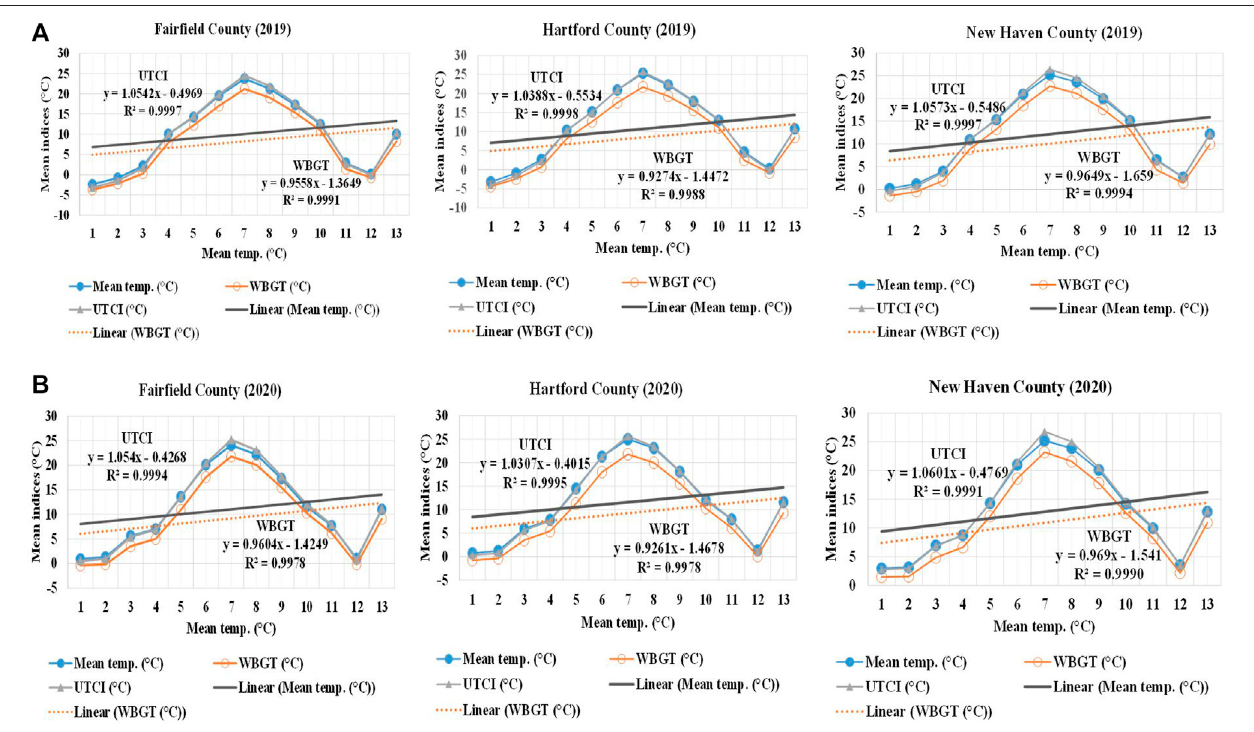
FIGURE10|(A) :CorrelationsbetweenmeantemperaturesandthermalindicesinFair fi eld (left) ,Hartford (middle) ,andNewHaven (right) in2019(pre-pandemic year). (B) : Correlations between mean temperatures and thermal indices in Fair fi eld (left) , Hartford (middle) , and New Haven (right) in 2020 (pandemic year).